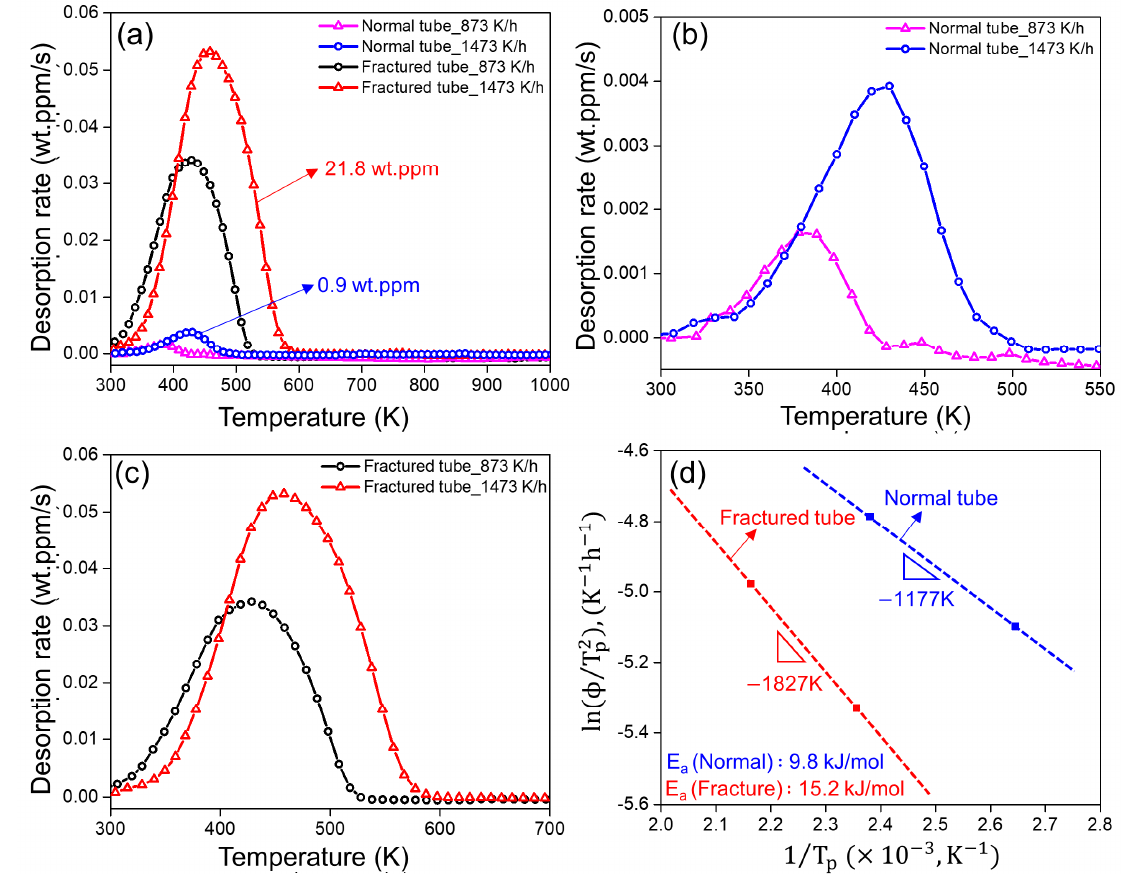
Figure 7. TDS analysis of normal and fractured tubes: ( a – c ) hydrogen desorption rate vs. temperature, ( d ) calculation of activation energy of trapping sites using a Kissinger equation.